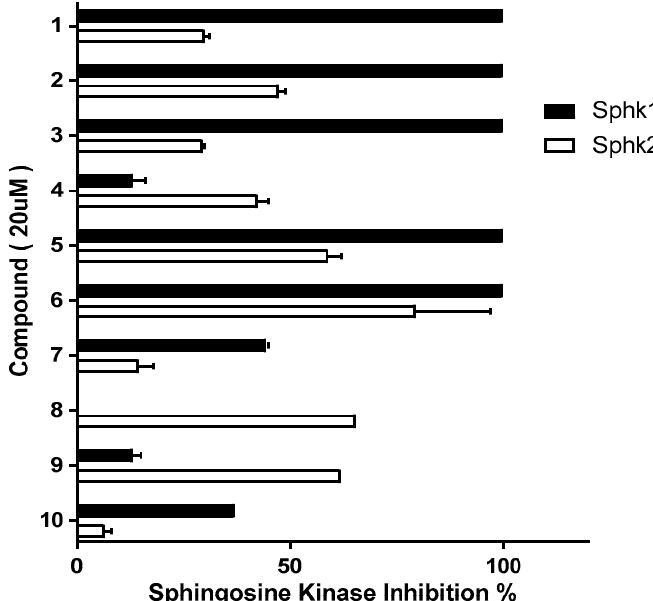
Figure 2. E ff ect of PF-543 ( 1 ) and derivatives ( 2 – 10 ) on SK1 / 2 Figure 2. Effect of PF-543 ( 1 ) and derivatives ( 2 – 10 ) on SK1/2 activity.